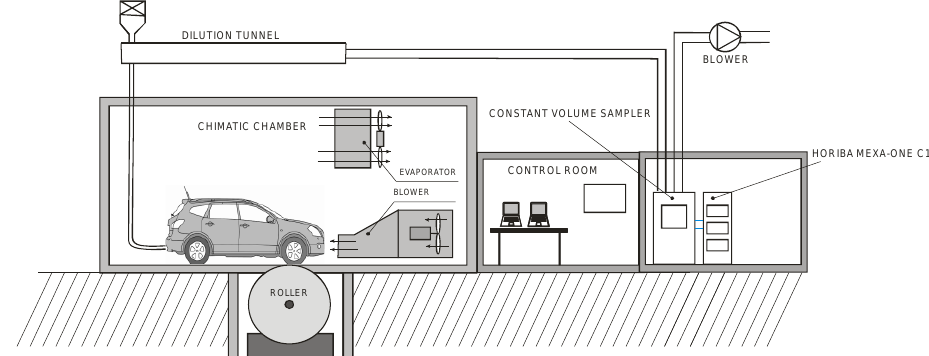
Figure 1. Scheme of the experimental setup.